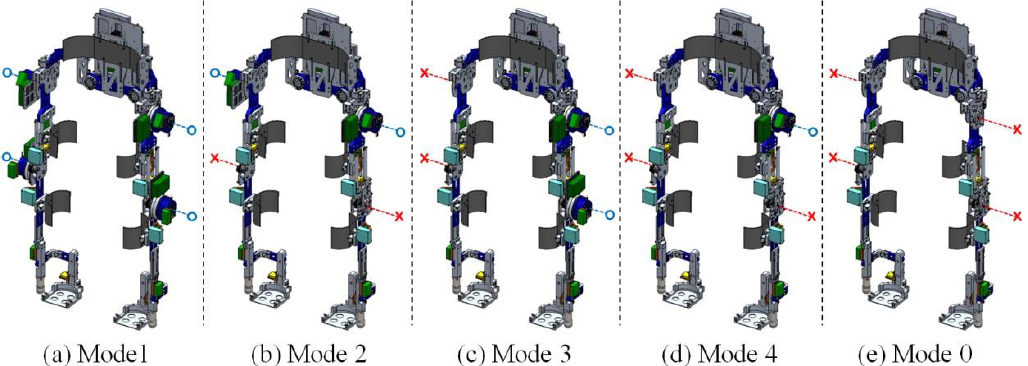
Figure 12. Configuration of the five modes of the exoskeleton according to the assembly of the actuation modules. The blue-circle and red-cross indicates whether the actuation module is assembled to the joint or not, respectively. Each mode of the exoskeleton can be used for the purpose of assisting ( a ) hip and knee joints of both legs; ( b ) hip or knee joints of both legs; ( c ) hip and knee joints of one leg; and ( d ) one of the joint of lower-limb. In the case of ( e ) mode 0, although it cannot assist the joints of a wearer by using actuation modules, it can be used to measure the motion of a wearer by using embedded sensors.